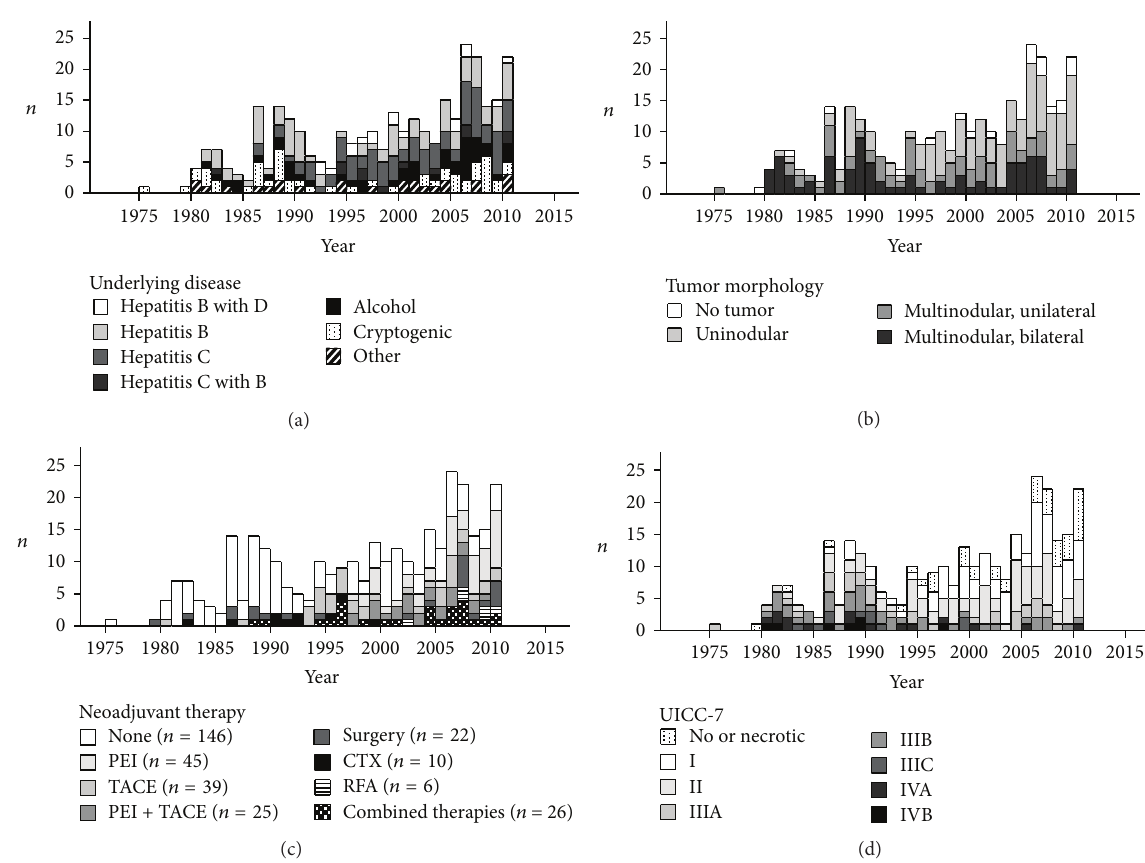
Figure 1: Annual proportions of underlying diseases (a), neoadjuvant therapies (b), UICC-7 staging (c), and tumor morphologies (d). (a) There was no significant change in annual proportions of recipients underlying diseases over time. (b) Tumor morphologies of transplanted HCC changed over time in the favour of uninodular and unilateral tumors. (c) The overall rate for neoadjuvant therapy as well as the diversity of different treatment combinations increased over time. This effect was caused due to new therapies that were introduced consecutively from 1975 to 2010 (surgery (S), chemotherapy (CTX), transarterial chemoembolisation (TACE), percutaneous ethanol instillation (PEI), selective internal radiation therapy (SIRT), and monoclonal antibodies (mAB)) . (d) Between 1975 and 2010 the proportion of low graded UICC-7 staged tumors increased